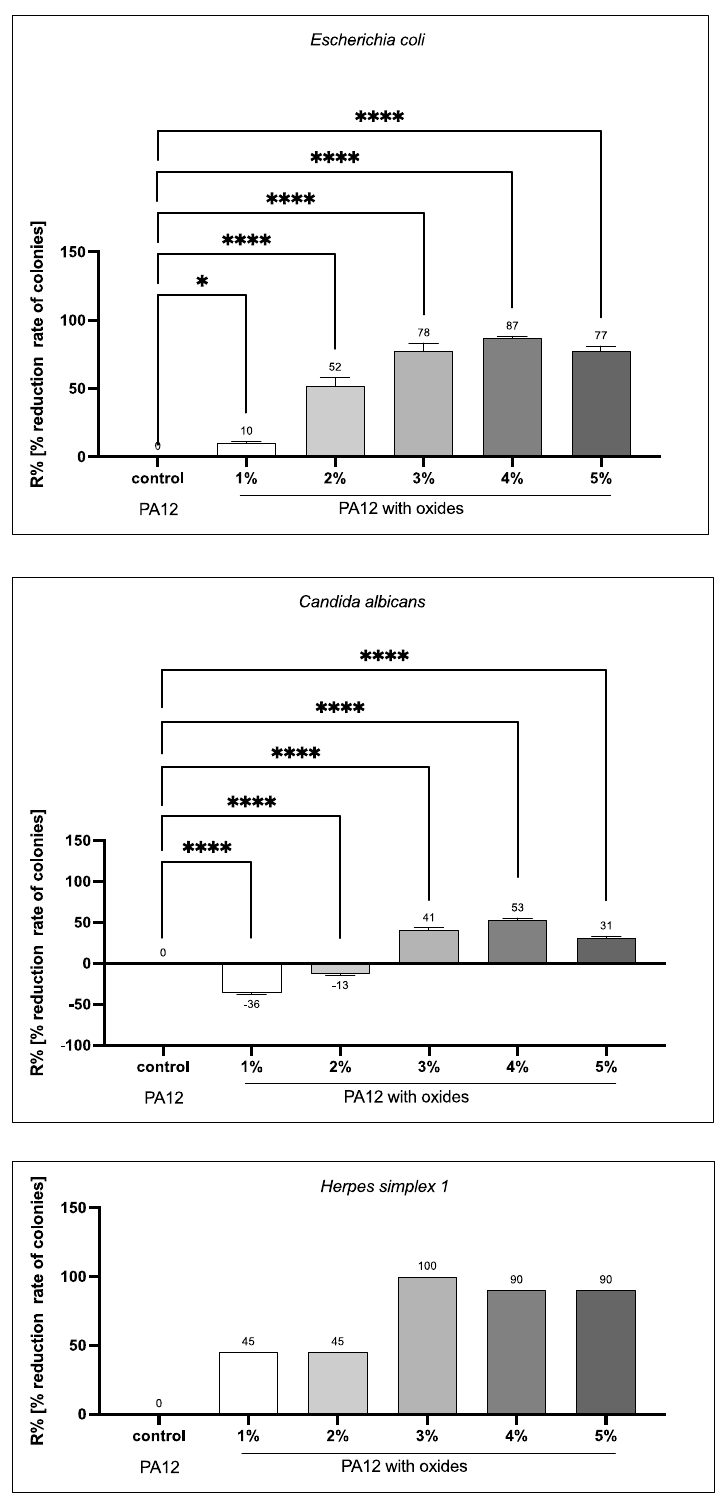
Figure 6. The antimicrobial activities in term of reduction (%) rate of colonies (CFU), against: Escherichia coli , Candida albicans and Herpes simplex 1. Differences with p < 0.05 were considered statistically significant. One asterisk (*) indicates p < 0.05, four asterisks (****) indicate p < 0.0001. Since the results for viruses are discontinuous, error bars, as well as one-way analysis of variance, cannot be added.